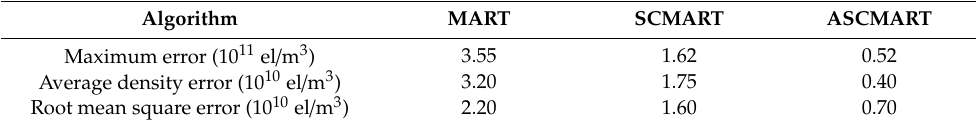
Table 1. Tomographic error statistics of the MART, SCMART, and ASCMART. Algorithm